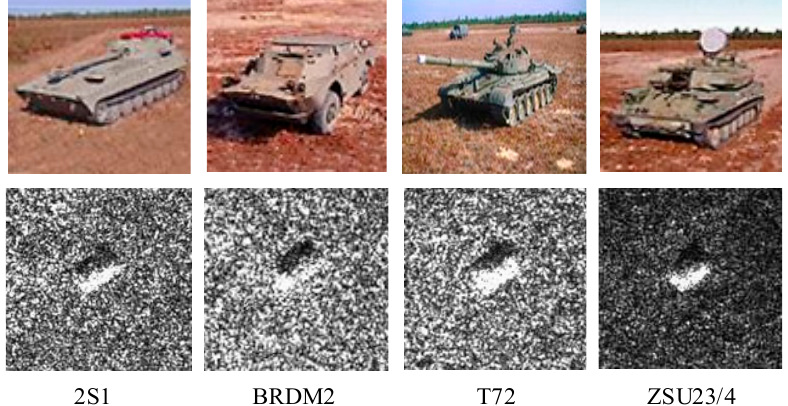
Figure 6. Comparison of recognition degree of feature maps.